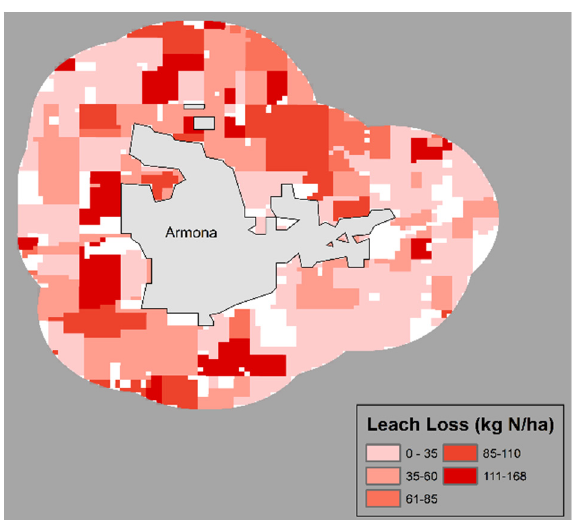
Figure 3. Nitrate leaching loss to groundwater (kg·ha − 1 ) occuring within a sample 1000 m buffer zone.